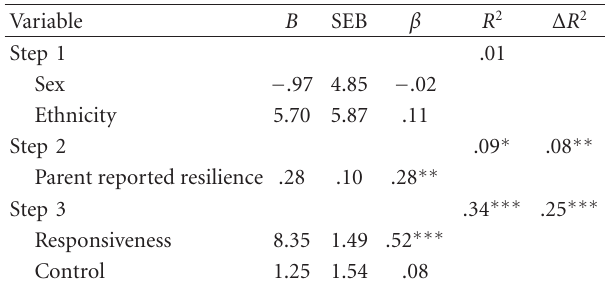
Table 3: E ff ect of parental responsiveness and psychological control in predicting child emotional resilience after controlling sex, ethnicity, and parent-reported child emotional resilience ( N =